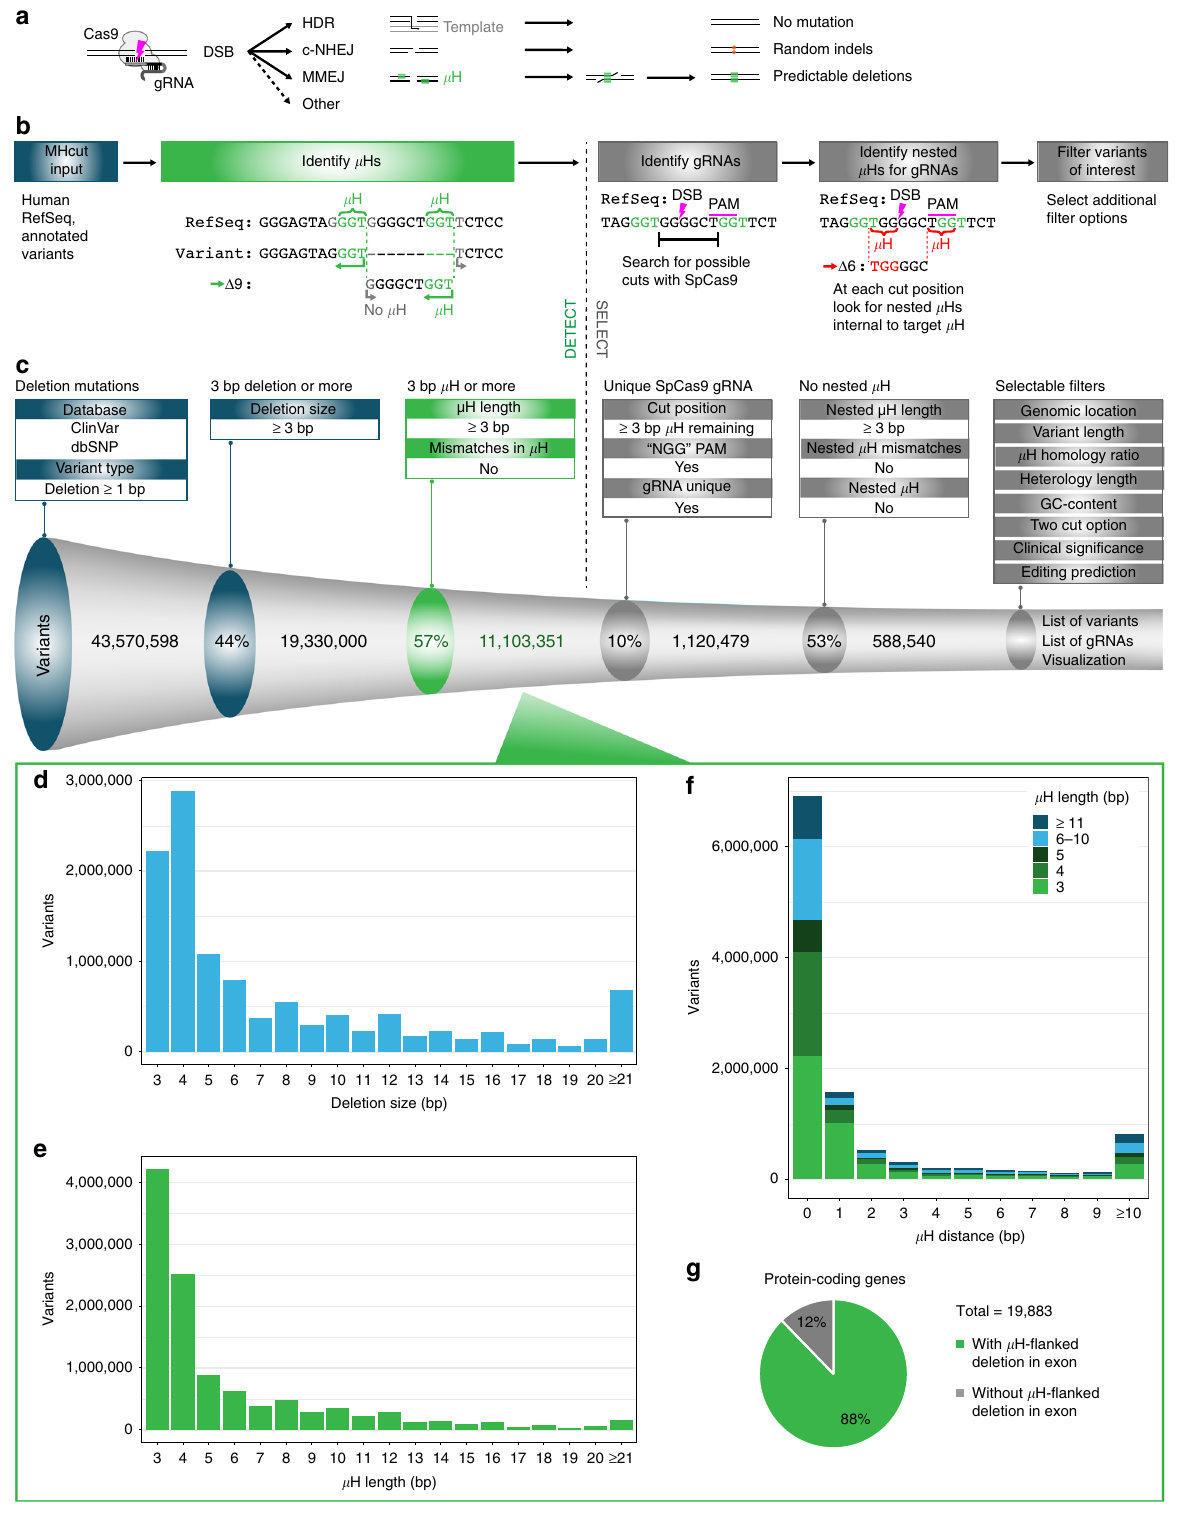
Fig. 1 Analysis of human deletion alleles for fl anking microhomologies ( µ Hs). a Overview of double-strand break (DSB) DNA repair pathways and their outcomes. homology-directed repair (HDR), classical non-homologous end joining (c-NHEJ), microhomology-mediated end joining (MMEJ). b Schematic of the MHcut tool used to identify the microhomologous sequences. microhomologies ( µ Hs, green) or nested µ Hs (red), SpCas9 PAM (underline) and DSB location (pink bolt). c Numbers for variant data input and result of fi lters applied to the MHcut tool output. bp, base pairs. d Distribution of µ H- fl anked deletion variants by deletion size. e Distribution of µ H- fl anked deletion variants by µ H length. f µ H- fl anked deletion variants plotted by µ H distance with µ H length indicated by fi ll color. g Percentage of protein-coding genes with µ H- fl anked deletion variant in exonic coding